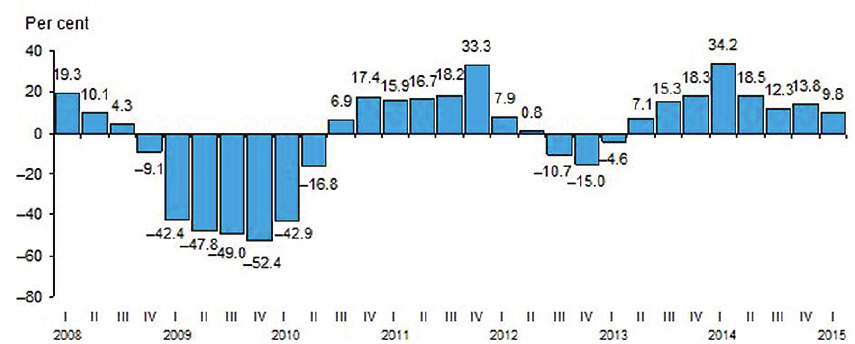
Figure 3. Changes in the volume of construction work carried out within the country, %, against the respective period of the previous year (Statistics Lithuania,